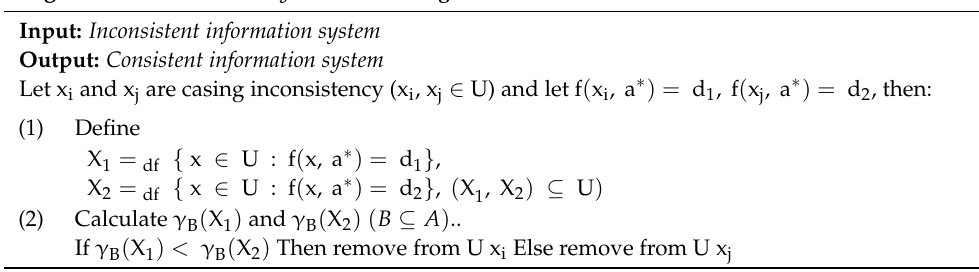
Algorithm 1 ( inconsistency elimination algorithm